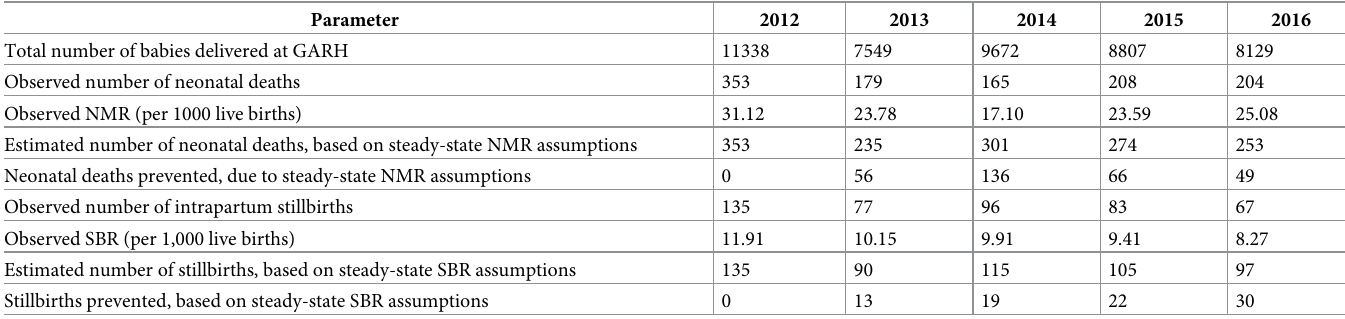
Table 5. Baseline data for the